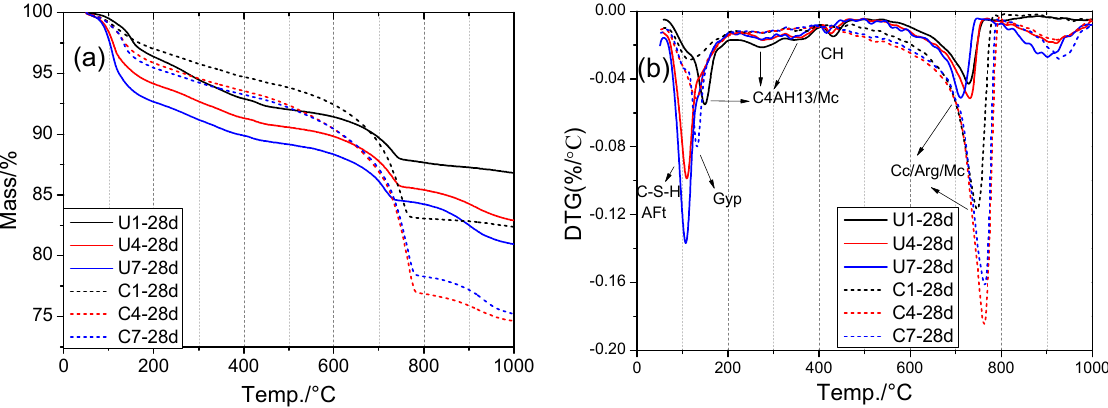
Figure 9. TG–DTG analysis of samples: ( a ) TG, ( b ) DTG (Cc: Calcite; Arg: Aragonite; Gyp: Gypsum; AFt: Ettringite; CH: Portlandite; Mc: Monocarboaluminate).